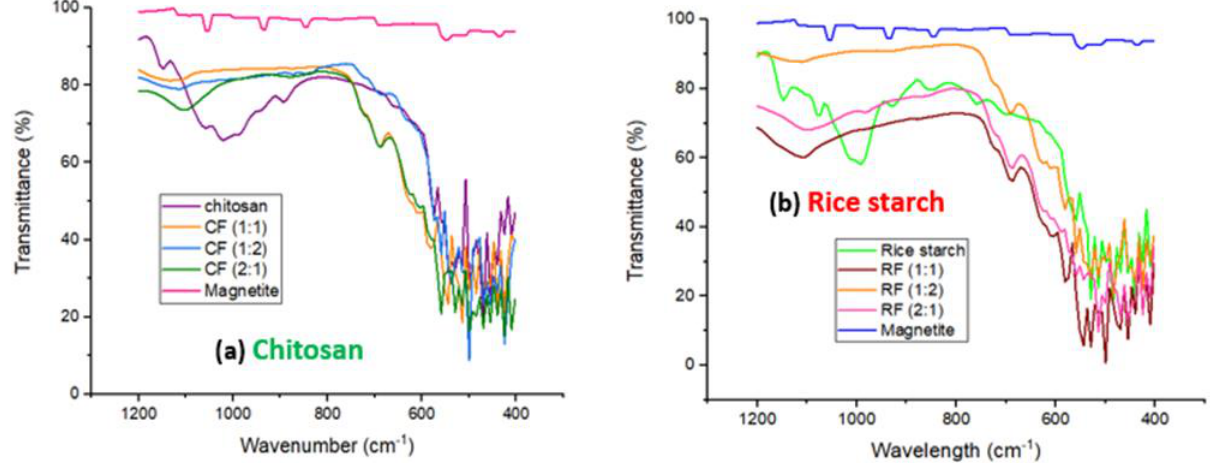
Figure 5. FTIR spectra ( a ) Chitosan and its magnetized coagulants; ( b ) Rice starch and its magnetized coagulants